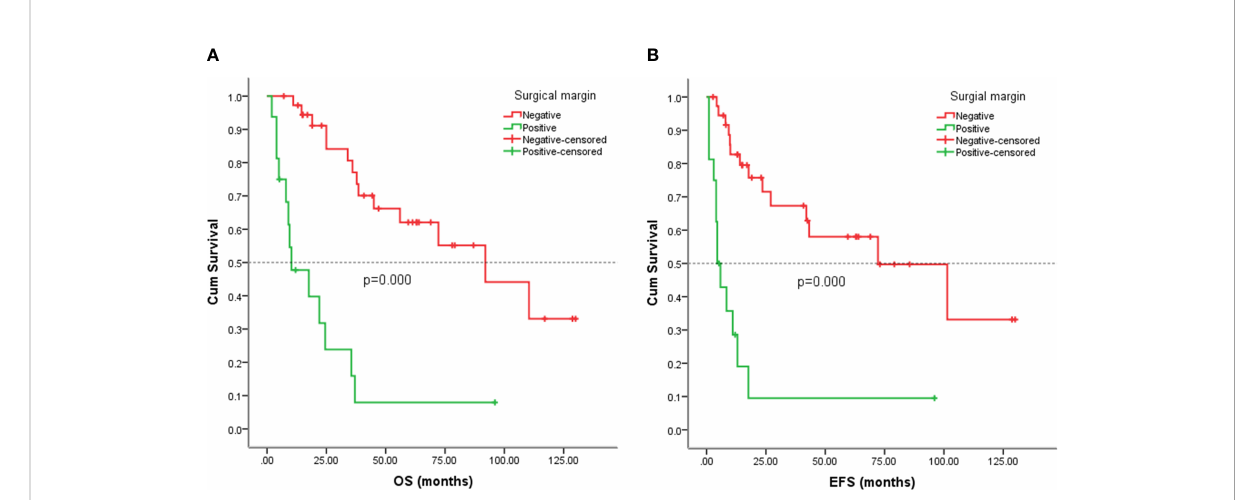
FIGURE 6 Kaplan-Meier analysis of OS and EFS for patients with positive or negative surgical margin. (A) Kaplan-Meier analysis of OS for patients with positive or negative surgical margin (p=0.000). (B) Kaplan-Meier analysis of EFS for patients with positive or negative surgical margin (p=0.000).